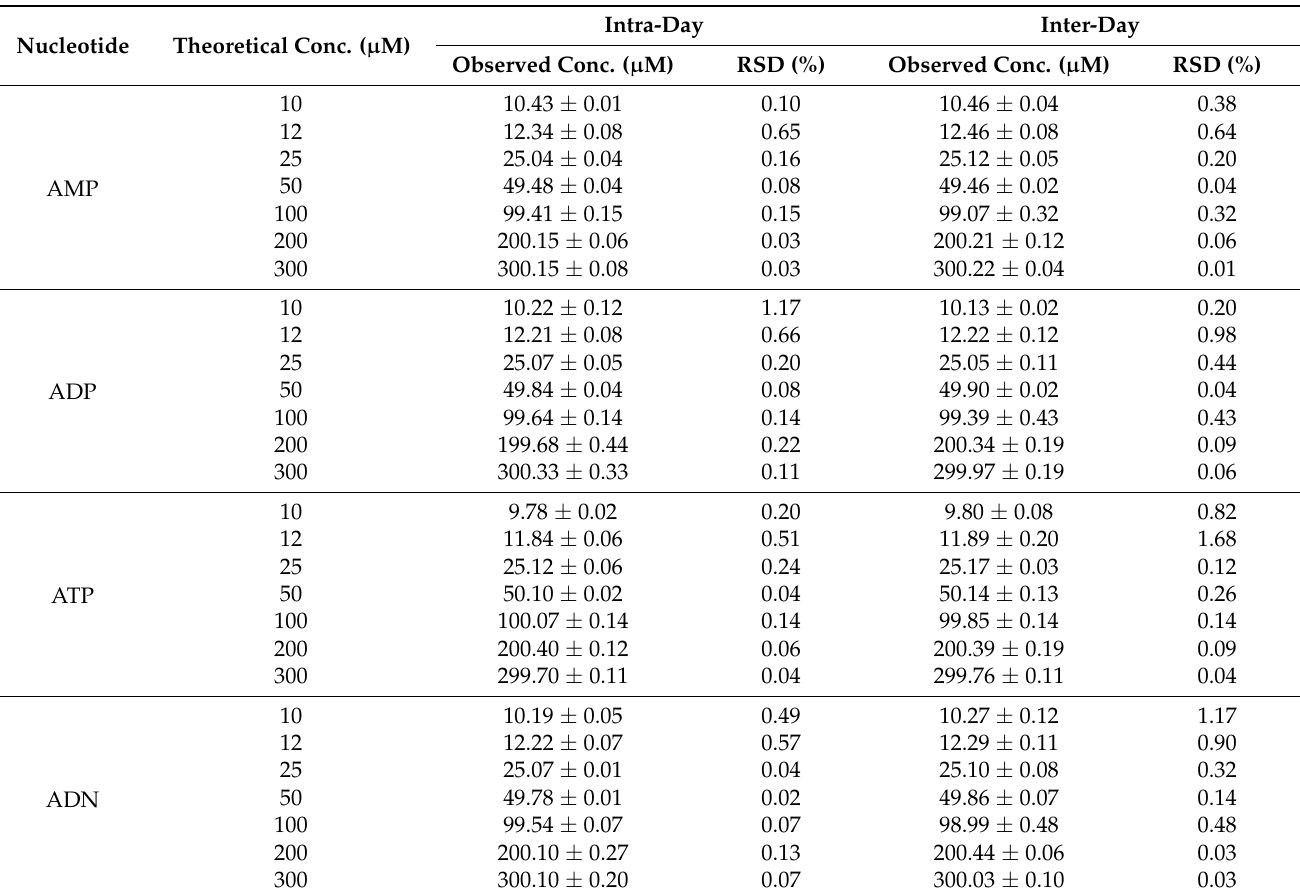
Table 2. Intra-day and inter-day accuracy for AMP, ADP, ATP, and ADN standards in concentration range from 10 to 300 µ